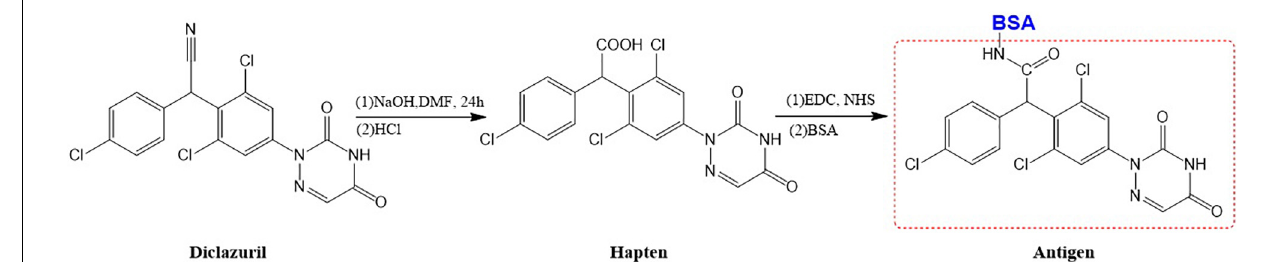
FIGURE 1 | Transformation path of diclazuril